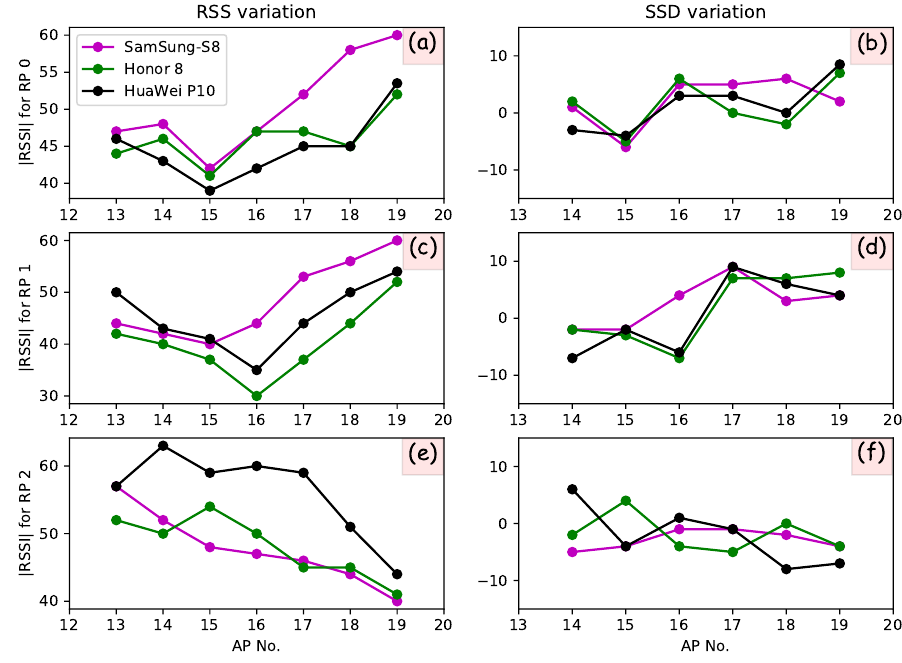
Figure 3. RSS versus SSD on three arbitrary reference points (RPs) collected by a Samsung-S8, Honor 8 and Huawei P10. ( a , b ) are performed on RP No. 0, ( c , d ) are performed on RP No. 1, and ( e , f ) are performed on RP No.